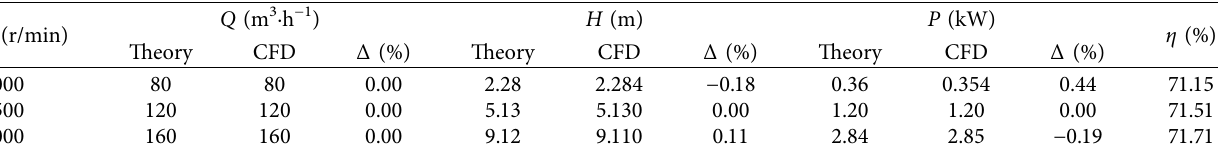
Figure 7: Speed triangle change in impeller inlet. Table 3: CFD and theoretical predicted BEP of MF-PAT at different rotational speeds.